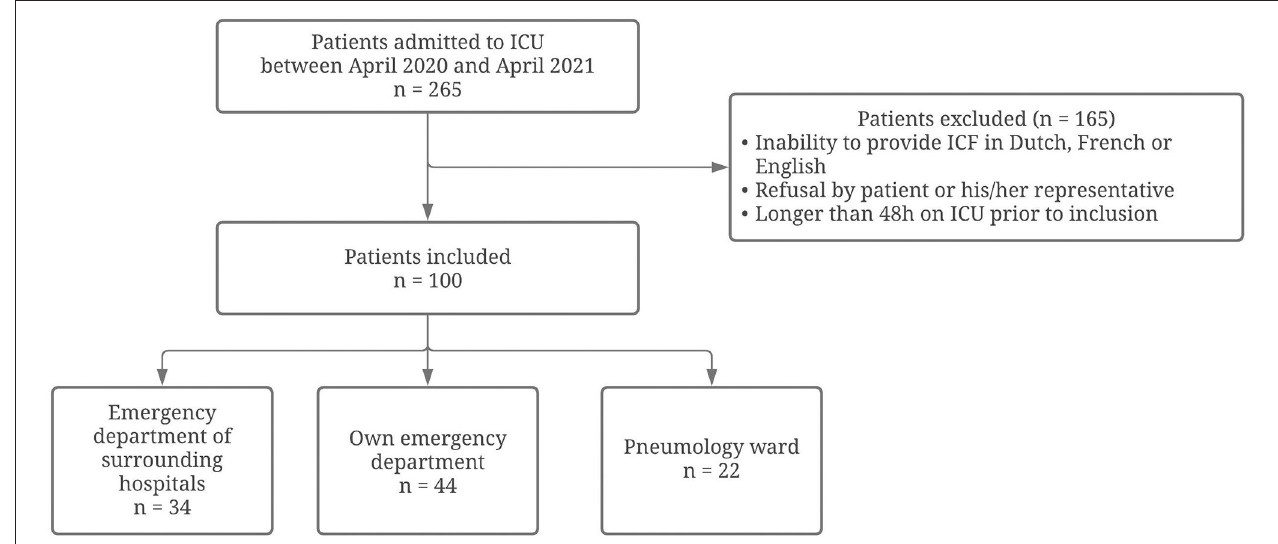
FIGURE 1 | Flow diagram on inclusion and exclusion of patients in the current study. Flow diagram reporting the numbers of included and excluded patients in the current study.